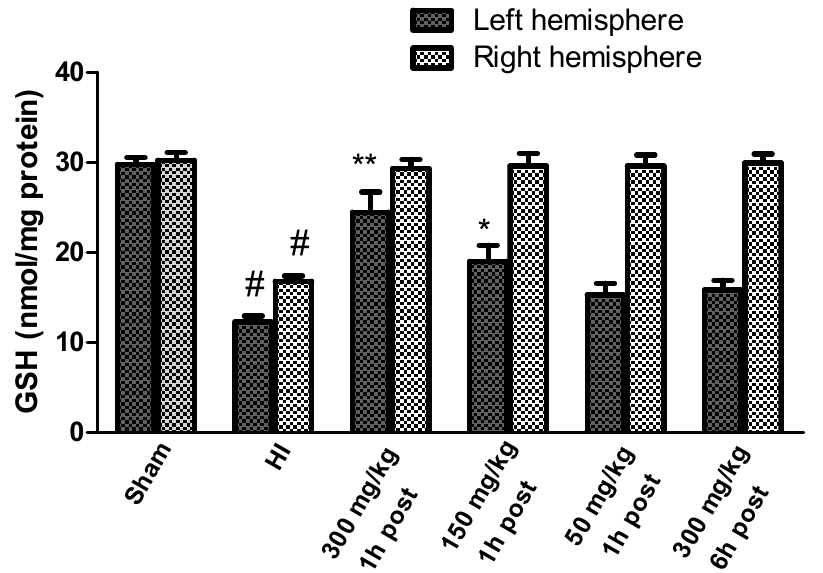
Figure 6. Effect of KYNA application on changes in the GSH concentration in the brains of rat pups after HI. The results are presented as the means ± SEM, n = 5–6; statistically significant differences: * p < 0.01, ** p < 0.001 compared to the HI group, # p < 0.001 compared to the sham-operated group. HI resulted in a significant decrease in GSH in both hemispheres to 41.3% and 55.5% of the control in the left and right hemispheres, respectively (Figure 6). KYNA applied in doses of 300 mg/kg and 150 mg/kg body weight 1 h after HI significantly restored the GSH concentration, whereas the application of KYNA in a dose of 50 mg/kg body weight did not result in a significant increase in GSH concentration compared to the HI group, similarly to 300 mg/kg applied 6 h after HI. However, KYNA in each of the investigated doses restored GSH concentration in the right hemisphere to the control level, independently of the time of